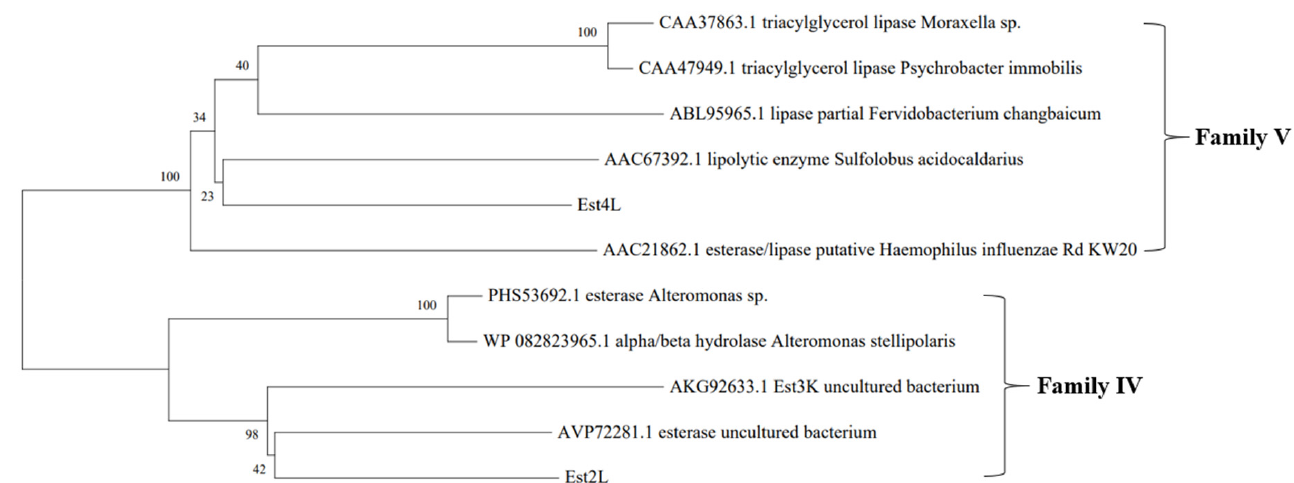
Figure 1. A phylogenetic tree of Est2L and Est4L. The tree is drawn to scale, and branch lengths are shown in the same units as those of the evolutionary distances used to infer the phylogenetic tree, using 12 amino acid sequences. Evolutionary analyses were conducted in MEGA X using the neighbor-joining method.